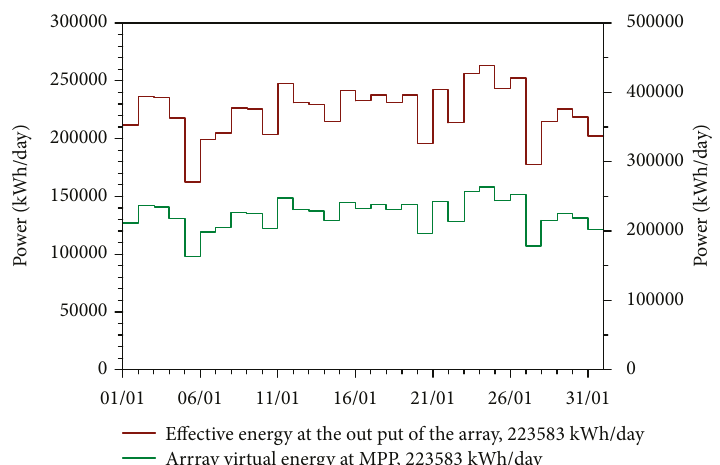
Figure 6: First month e ff ective energy at the output of the array and array virtual energy at MPPT.